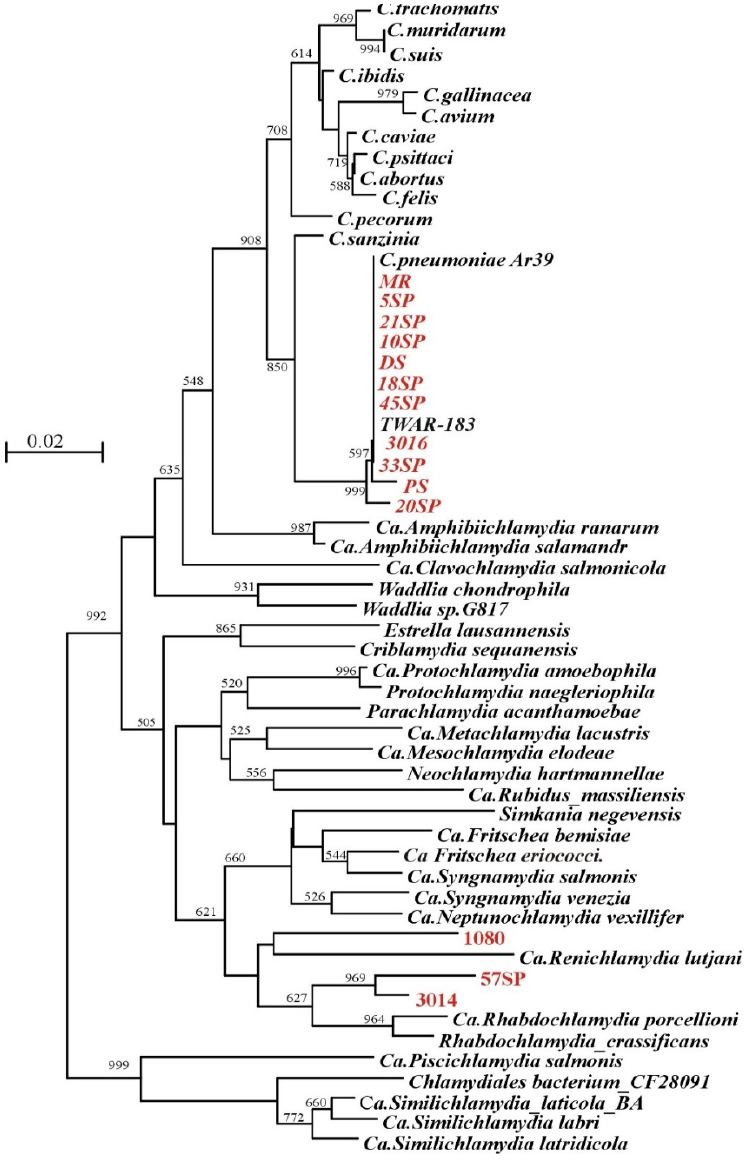
Figure 2. Phylogenetic tree showing the phylogenetic relationships of species of the order Chlamydiales and our specimens (“neighbor-joining algorithm”). A tree based on a comparison of a 346 bp amplified 16S rDNA region flanked by Chp up and Chp down primers. Clinical samples are marked in red. The length of the individual branches corresponds to the extent of the divergence. The stability of the individual branches was evaluated using the “bootstrap” method with 1000 repetitions, and only values greater than 50% are given. Sequences of Chlamydia species were derived from [59].